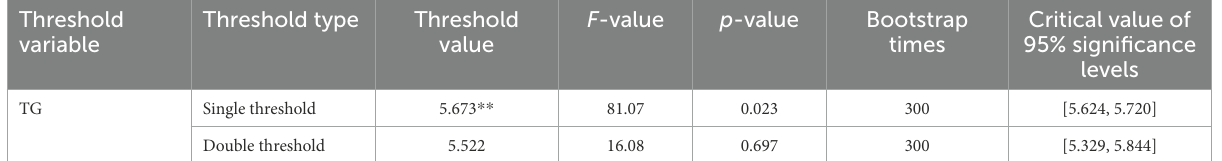
TABLE 6 Results of the threshold effect